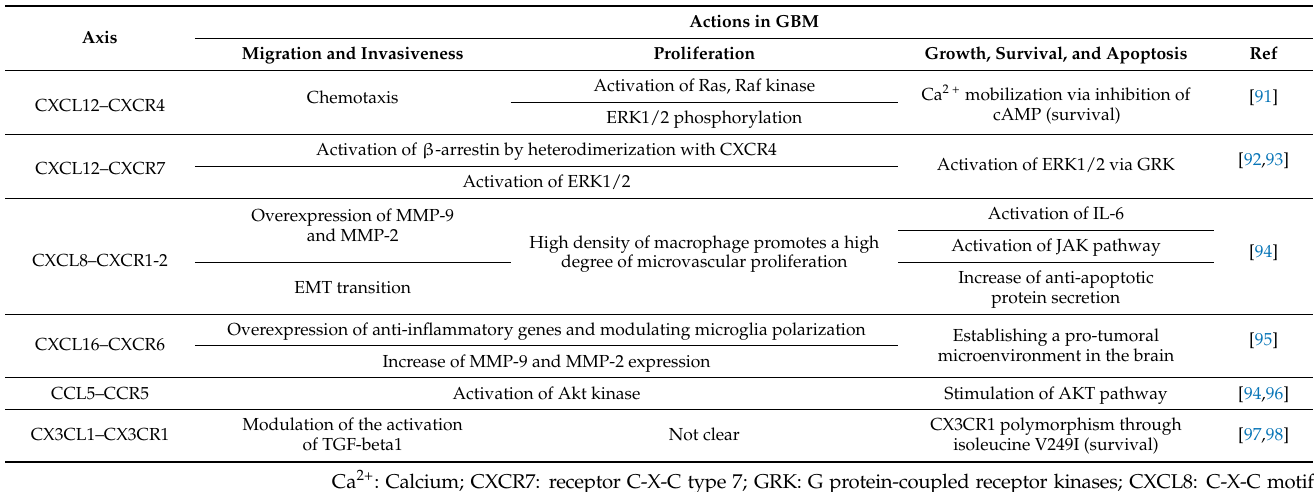
Table 1. Some activated axes in GBM and their